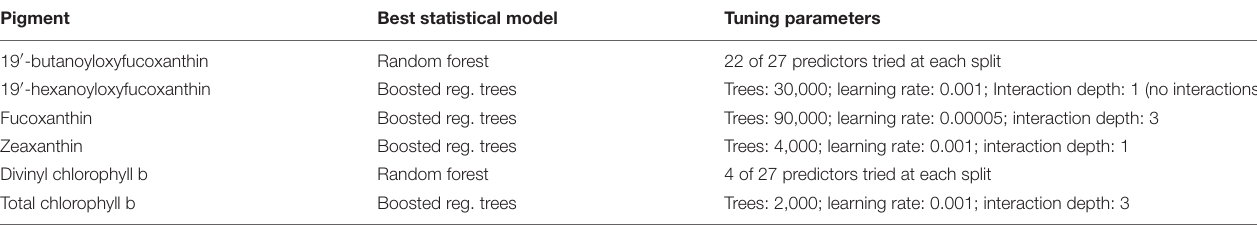
TABLE 3 | Tuning parameters of the best statistical models, obtained by training and tuning on the full match-up data set. Pigment Best statistical model Tuning parameters